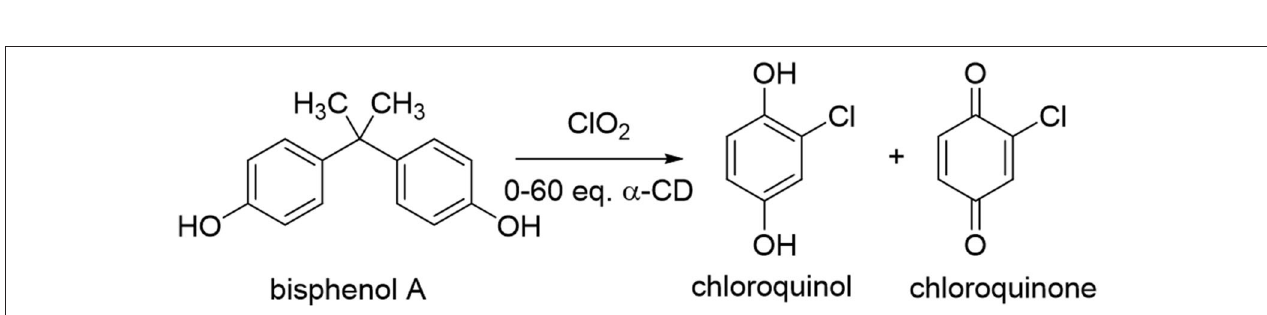
FIGURE 2 | (A) Illustration of how the addition of α -cyclodextrin dramatically increases the oxidation to chlorination ratio in bisphenol A degradation at room temperature. (B) Illustration of oxidation and chlorination products that are produced from the chlorine dioxide-mediated decomposition of bisphenol A. Only one set of experiments was conducted to screen the reaction temperature; after determining that significant amounts of starting material remained; additional experimental variations were pursued. The red line represents the best linear fit to the data; Equation: y = 0.6821x + _0.4289; R 2 = 0.9715.